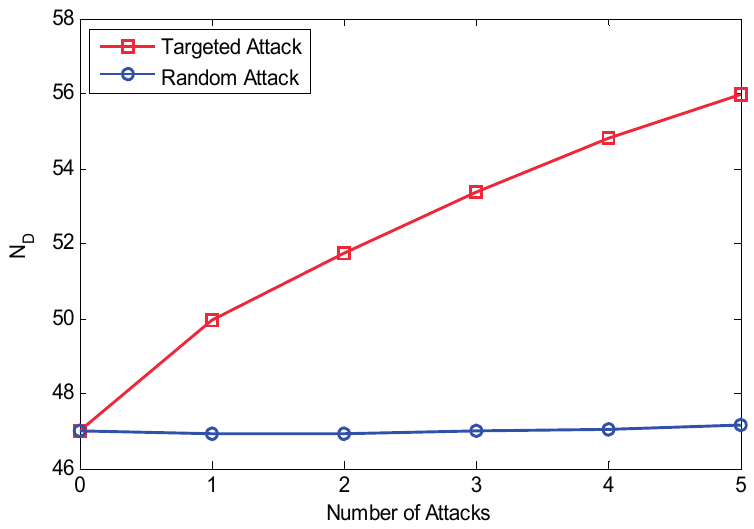
Figure 5. Increase in N D of the network after attacks.